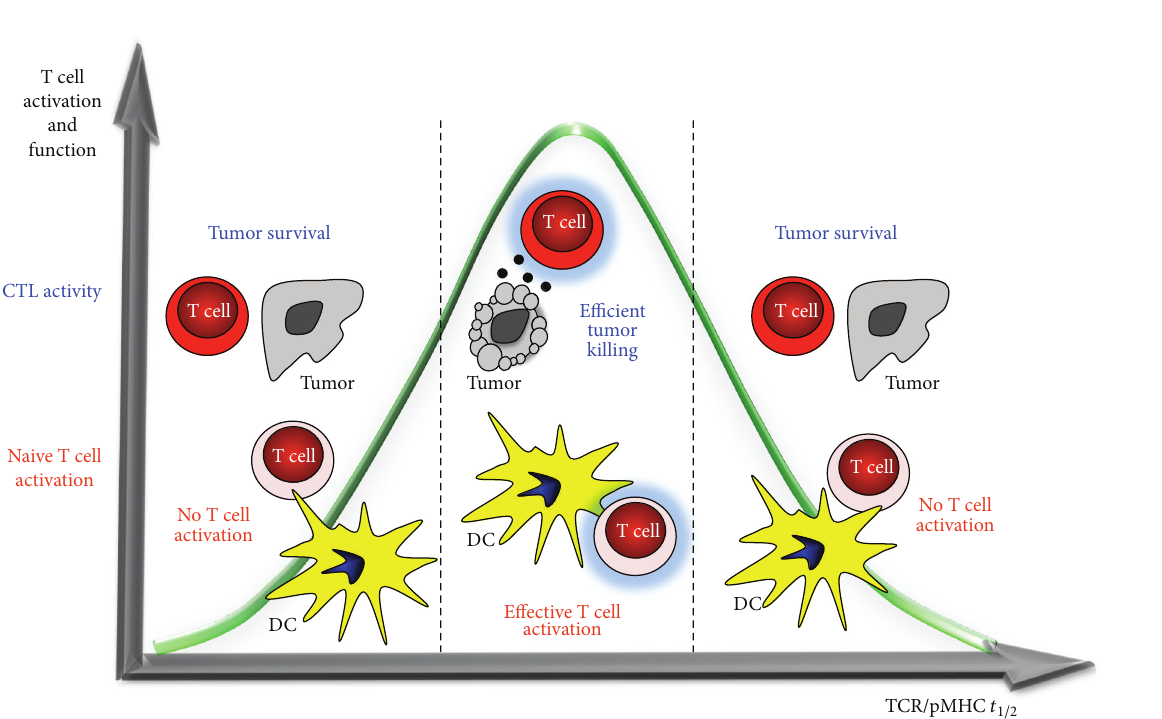
Figure 3: Effects of TCR/pMHC kinetics ( 𝑡 1/2 , half-life) on T cell activation for na¨ıve and effector T cells. TCR/pMHC interactions that are short-lived are discriminated by the TCR as nonligands in such a way to avoid the recognition of self-pMHC complexes and the activation of autoreactive T cells that may be harmful for the host (left). A model for such discrimination is termed the kinetics proofreading model . On the other hand, experimental data from our group supports a model for TCR serial engagement for T cell activation (right). That is, prolonged TCR/pMHC half-life interactions also fail to efficiently activate T cells in response to these ligands. Combining both, the kinetics proofreading model and the TCR serial engagement model , an optimal TCR/pMHC dwell time is required for efficient T cell activation (center). Optimal T cell activation at intermediate TCR/pMHC half-life interactions is supported by in vitro results using a viral peptide (na¨ıve T cell activation) and in vivo data assessing either bacteria infection or tumor growth in mice (CTL